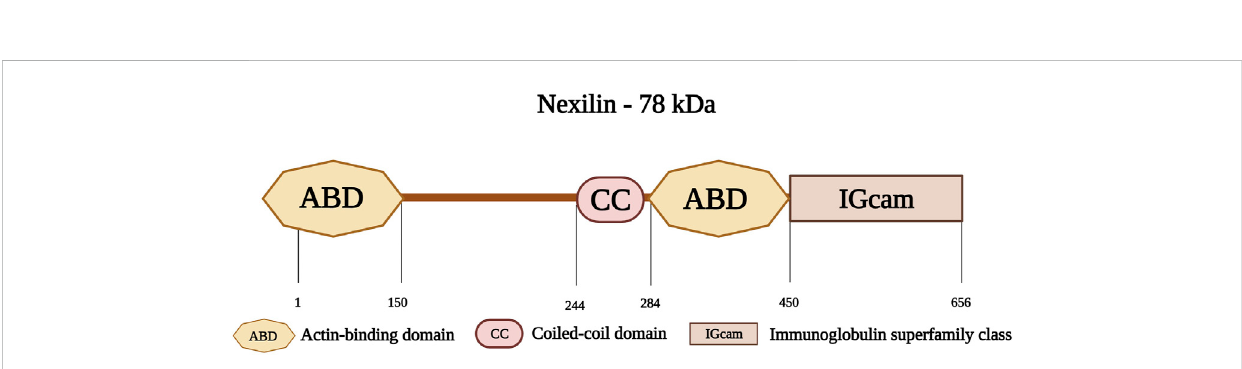
FIGURE 9 Schematic representation of nexilin with its fi rst actin-binding domain (ABD) at the amino-terminus followed by a coiled-coil domain (CC) at the